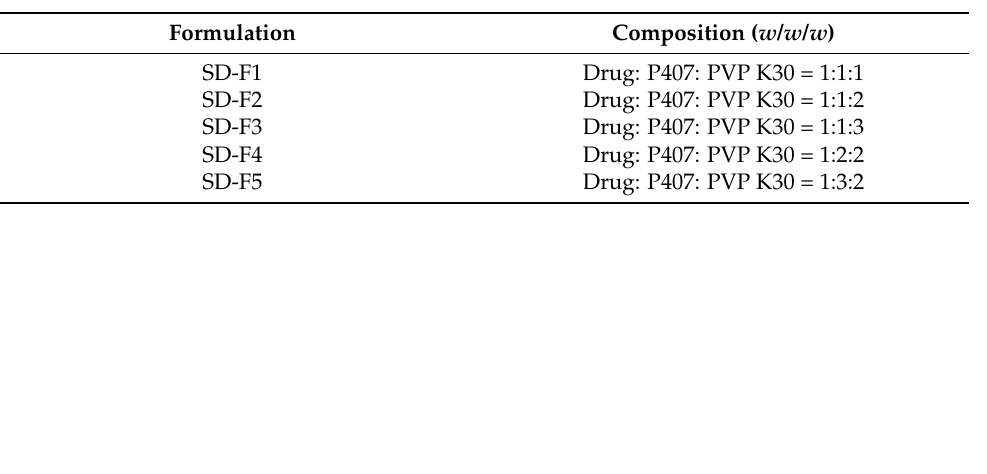
Table 1. Composition of ternary solid dispersions of